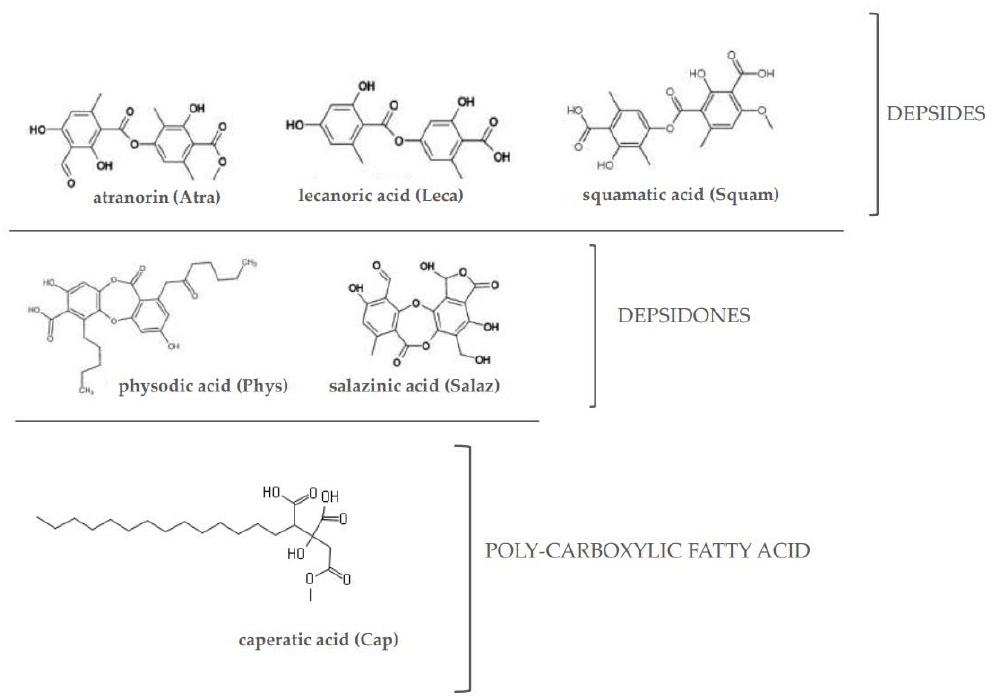
Figure 1. The chemical structure of the investigated lichen-derived